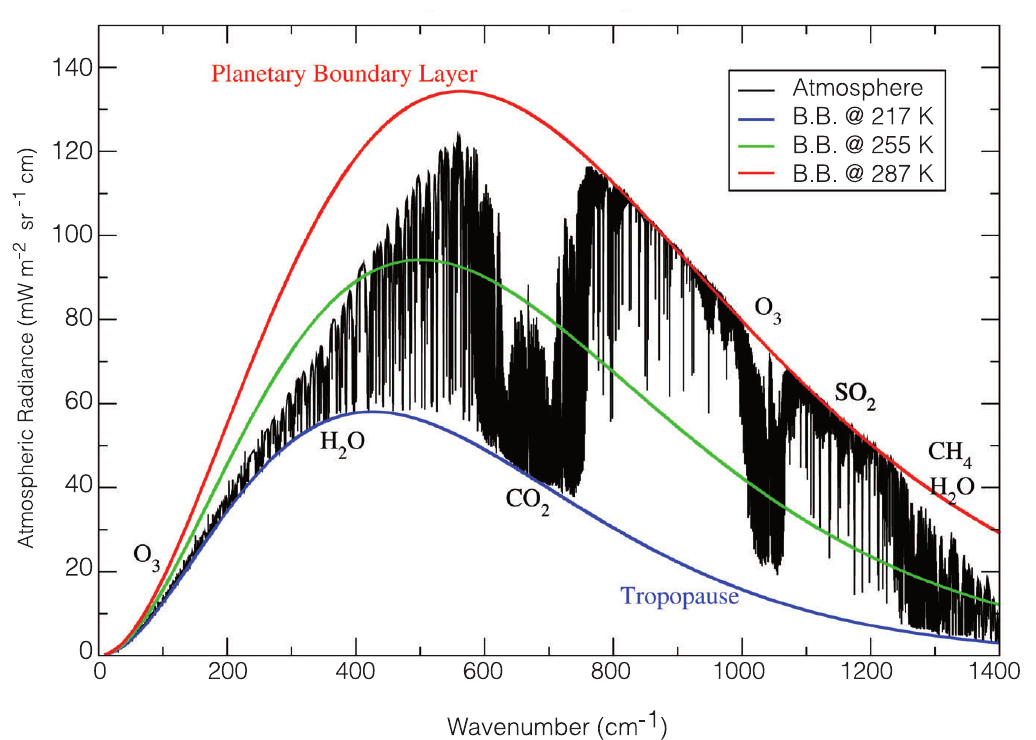
Fig. 1. Simulated emission spectrum of the Earth’s atmosphere in the zenith direction.